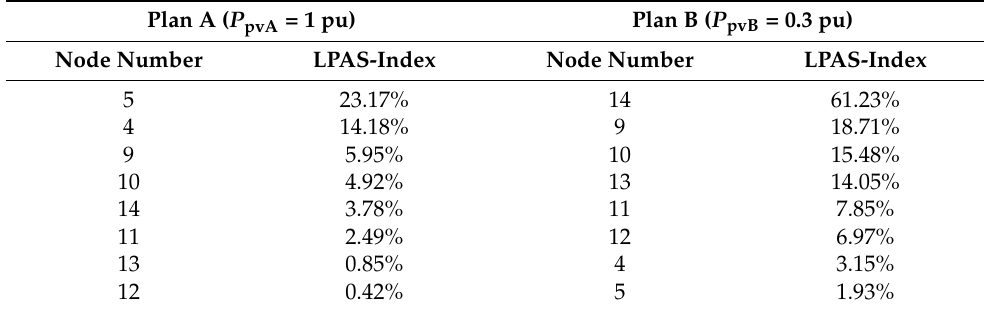
Table 2. LPAS-index values of load nodes under Plan A and Plan B (Load multiple lm = 1 pu). Plan A ( P pvA = 1 pu) Plan B ( P pvB = 0.3 pu)